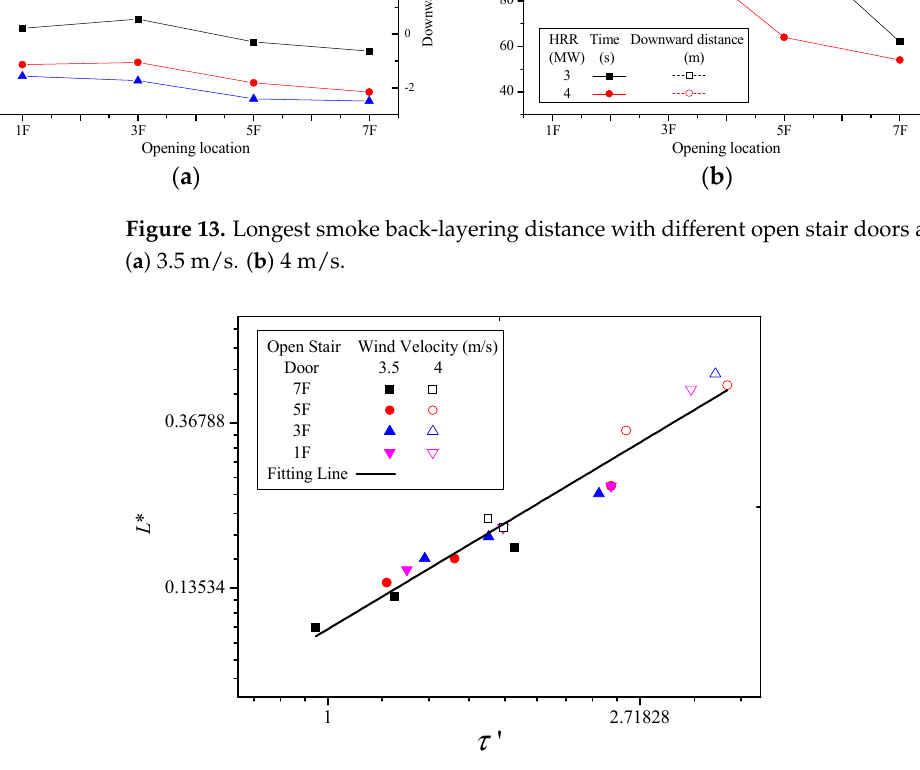
Figure 14. Dimensionless back-layering distance L * versus dimensionless back-layering time '